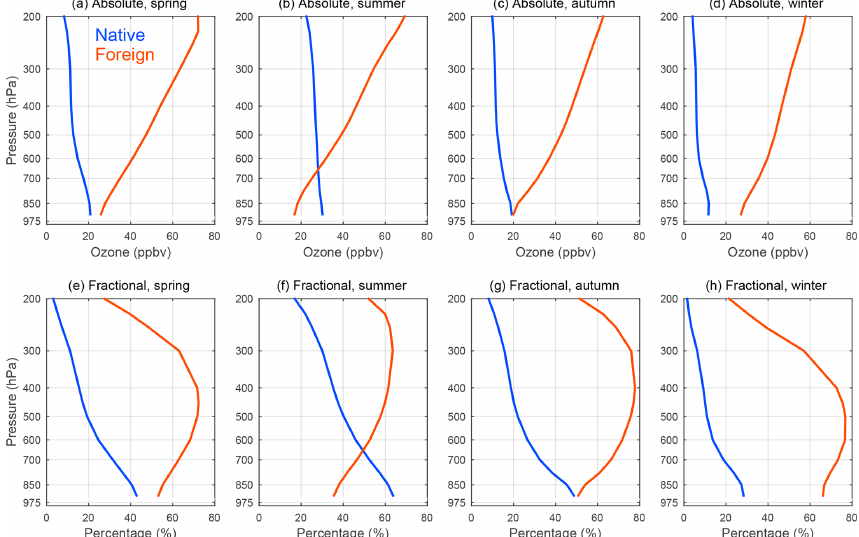
Figure 4. ( a – d ) Vertical variation in native ozone (in blue) and foreign ozone (in red) (in ppbv) averaged over East Asia by season in 2005. ( e – h ) The same as ( a – d ) but for the fractional contribution (in %) of each component to ozone in the East Asian troposphere at each